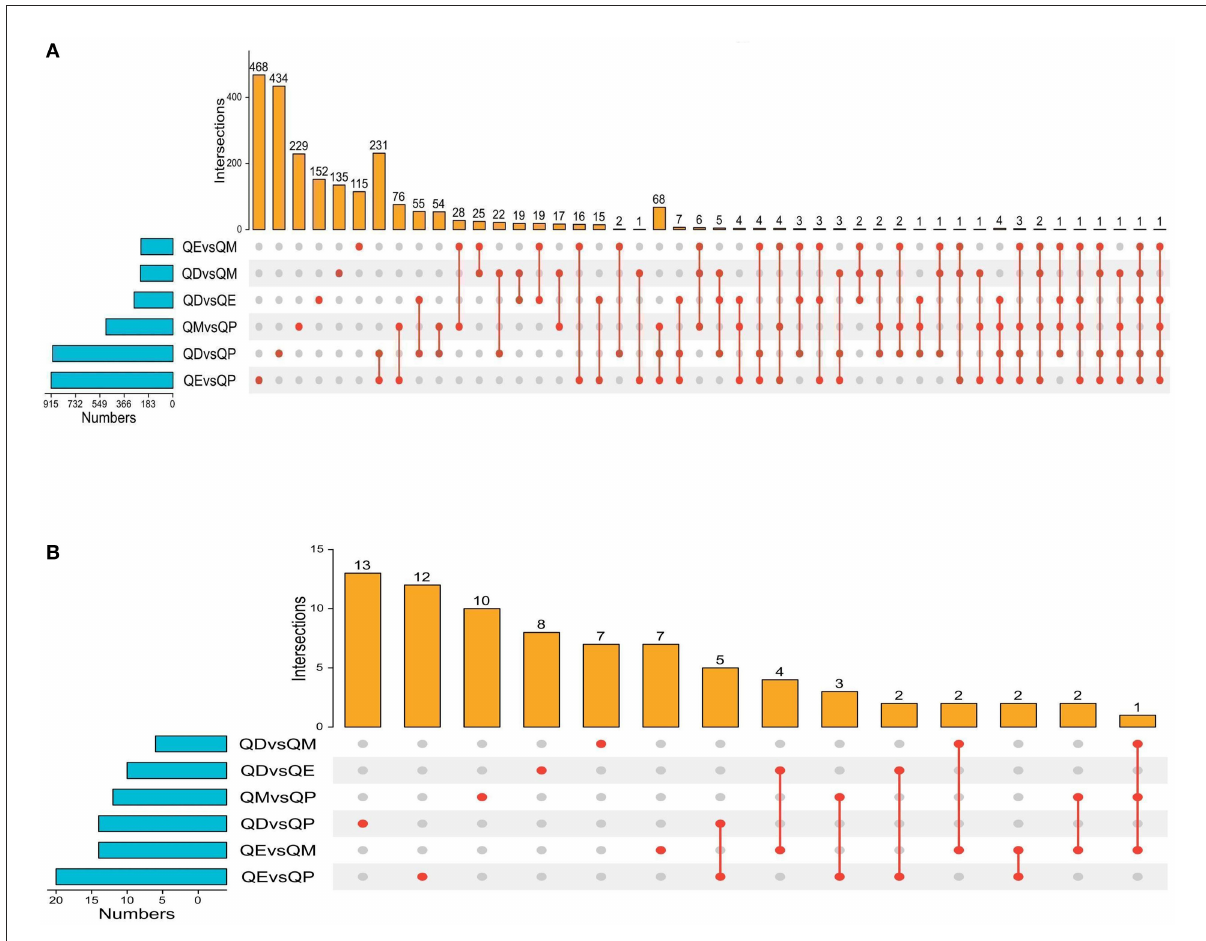
FIGURE3 Upset plot diagram of the gene comparison result. (A) Upset plot diagram was employed to intersect the six gene sets and obtained 2245 common DEmRNAs. (B) Upset plot diagram of all DELncRNAs numbers among the six gene